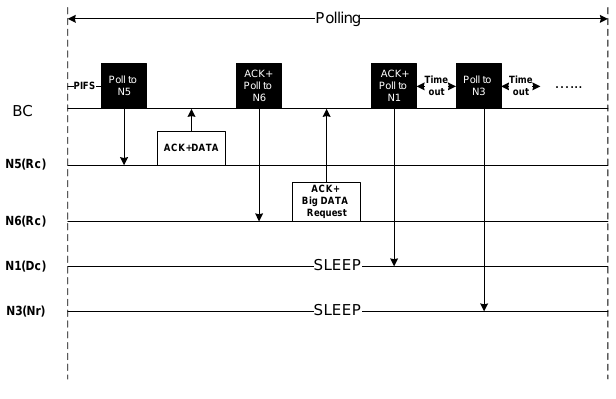
Figure 7. Communication during Polling period.